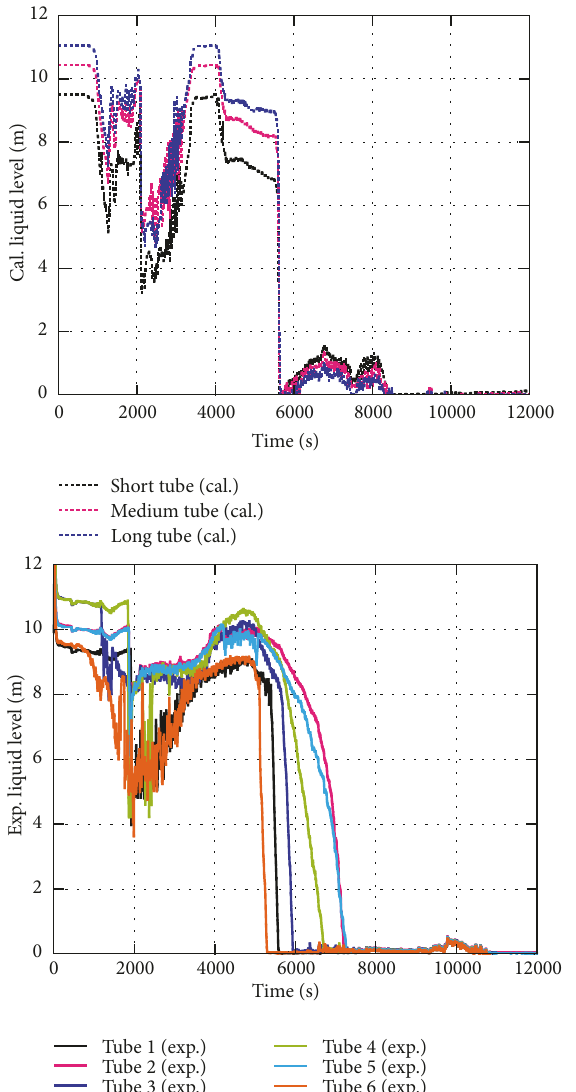
Figure 19: TR-LF-17testand RELAP5 results for SG U-tubeupflow- side collapsed liquid level in loop B.